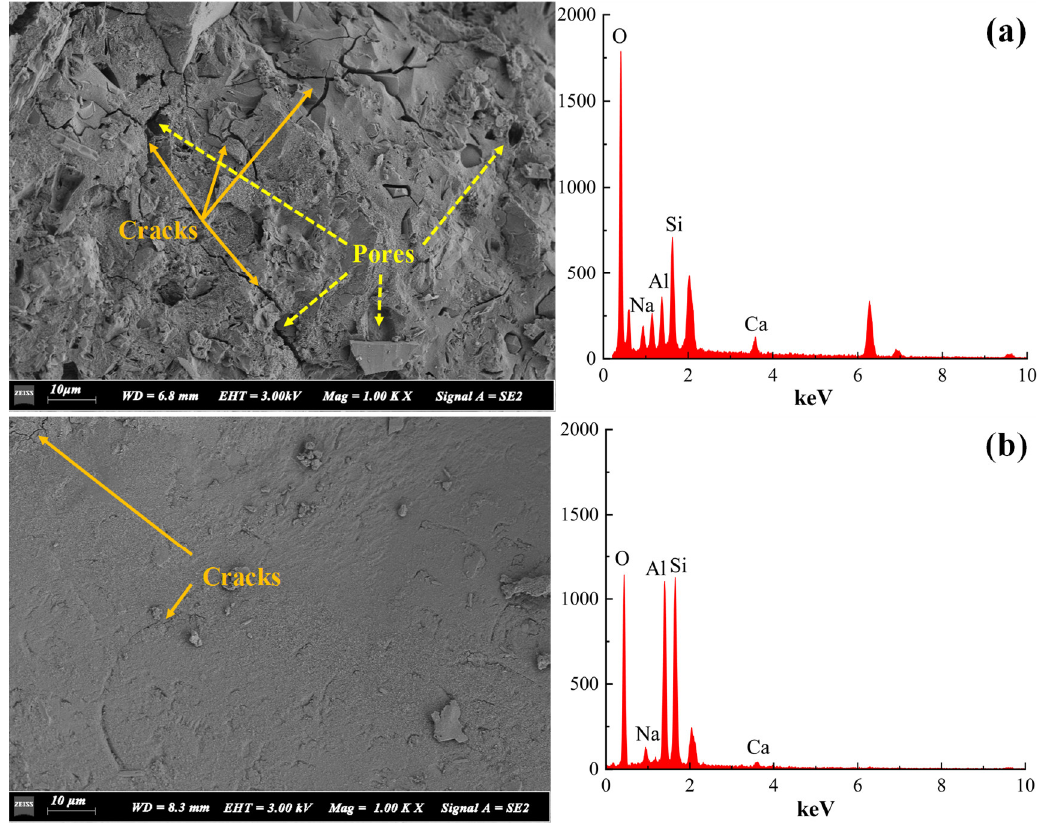
Figure 8. SEM and EDS results of the CGBGM: ( a ) 3 d; ( b ) 28 d. Moreover, the EDS results indicated that the primary elements of the hydration prod- ucts detected in the CGBGM were oxygen, calcium, sodium, aluminum, and silicon ele- ments. With the increase in curing ages, the calcium-to-silicon ratio (Ca/Si) decreased from 0.5 to 0.06, and the calcium-to-aluminum ratio (Ca/Al) decreased from 0.25 to 0.05. There- fore, many aluminosilicate products are generated during the curing process, which is consistent with the conclusion in the literature [32,35]. 3.5. Drying Shrinkage Figure 9 displays the differences in the mass-loss rate and drying shrinkage of the OPCM and CGBGM. It can be seen that the mass-loss rate and drying shrinkage of the OPCM and CGBGM exhibit a positive correlation with curing age. The curve of the mass- loss rate and drying shrinkage with curing age can be divided into the rapid increase, slow increase, and stabilization stages. Compared to the OPCM, the CGBGM has a higher mass-loss rate and drying shrinkage. The mass-loss rate and drying shrinkage of the CGBGM at 180 days increased by 95.20% and 78.08%, respectively. This is because the geopolymer system contains more free water than the cement-based material system [21]. Previous studies found that the drying shrinkage of low-calcium geopolymers was pri- marily caused by the evaporation of internal water [37,38]. Moreover, the low-calcium geopolymers are denser than cement-based materials, and there are many capillary pores. Therefore, the free water will rapidly evaporate when it is placed in a dry environment after hardening, leading to greater capillary pressure and more significant drying shrink- age [39,40]. The high drying shrinkage was an important factor limiting the wide applica- tion of the CGBGM. Ma et al., found that the dry shrinkage of the CGBGM is 2.01–3.05 times that of the OPCM [21]. Wang et al., implied that fly ash and MgO expansive agent could effectively reduce the drying shrinkage of face slab concrete [41–43]. Thereby, sev-